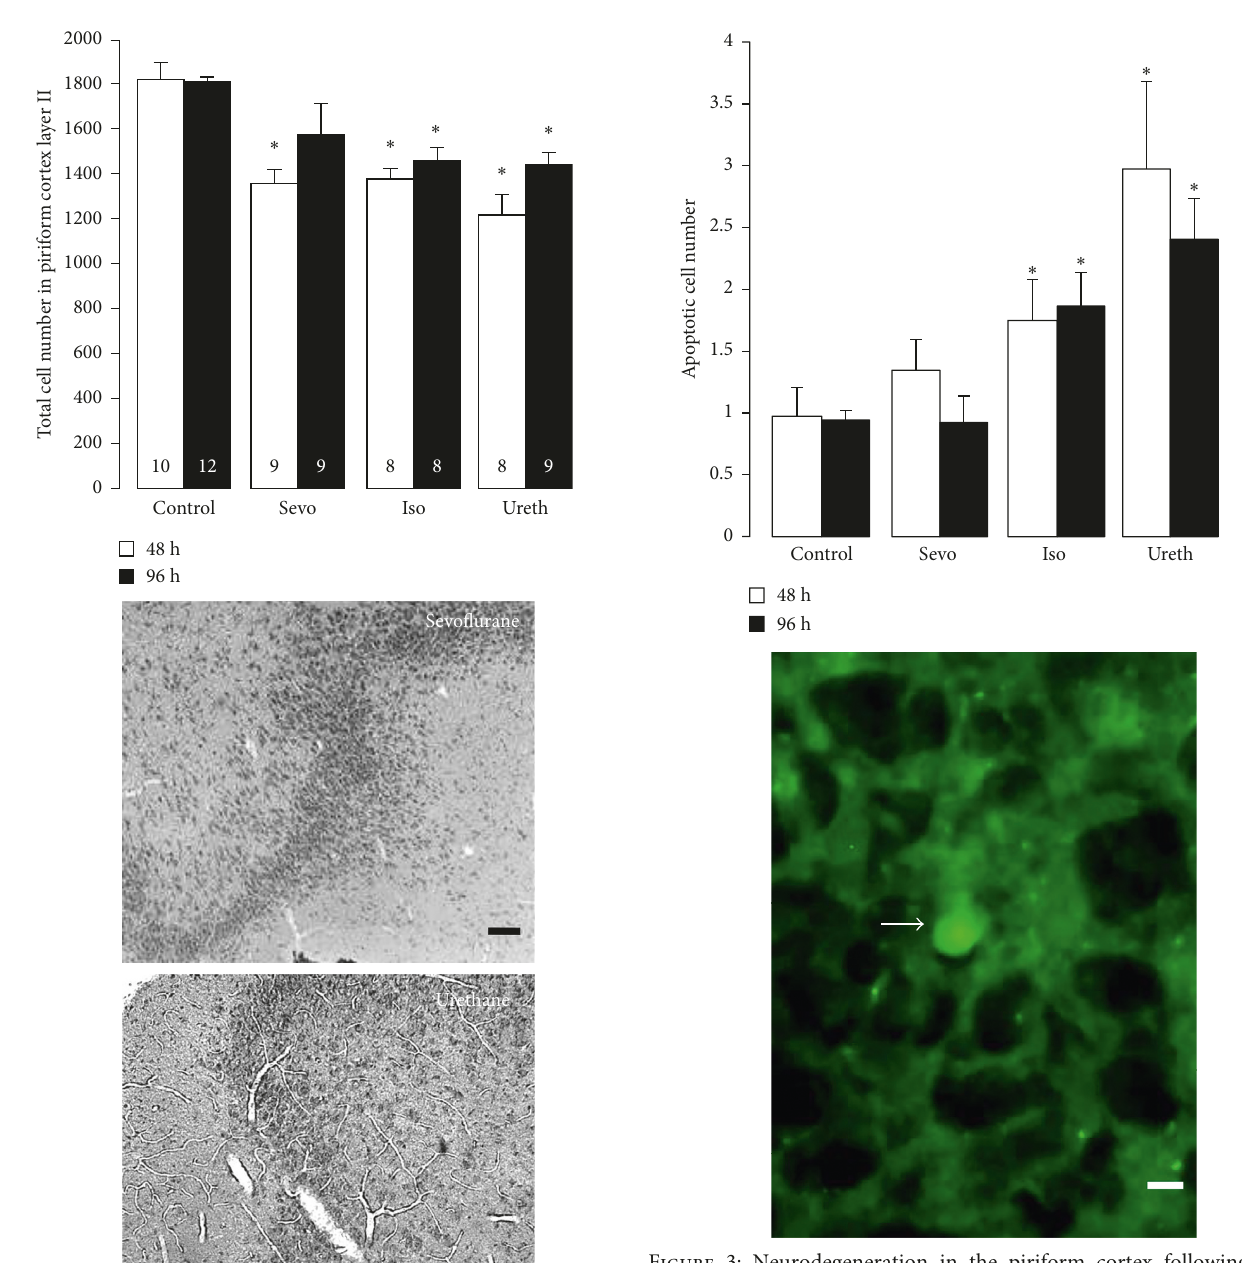
Figure 3: Neurodegeneration in the piriform cortex following anesthetic exposure. Data represent the mean SEM of total dying cells in layer II of the piriform cortex in animals sacrificed 48h and 96h after anesthetic exposure on PD15 (numbers of animals as per ± Figure 2). Dying cells were initially identified in sections stained Figure 2: Neuronal integrity in the piriform cortex following an- with H&E, as having a shrunken pyknotic nucleus set in an in- esthetic exposure. Data represent the mean SEM of total cell tensely eosinophilic cytoplasm. In serial eosin Y-stained sections, numbers in layer II of the piriform cortex in animals sacrificed 48h they also fluoresced brightly under UV light. The number of dying and 96h after anesthetic exposure on PD15. Values were calculated ± cells was calculated using unbiased stereological techniques, and using unbiased stereological techniques, and those differing signif- those differing significantly from vehicle-exposed controls are icantly from vehicle-exposed controls are indicated by an asterisk P indicated by an asterisk ( 0 . 05). Representative eosin Y-stained P ( 0 . 05). Representative images of H&E stained sections of the section of the piriform cortex (layer II) is shown under UV mi- ∗ piriform cortex (layer II) are also shown (scale bar 100 µ M). ∗ (cid:31) croscopy with a fluorescing, dying cell indicated by an arrow (scale < Pictures show the characteristically dense layer II, which is occupied < bar 20 µ M). The image is from an animal sacrificed 96h following primarily by the somata of pyramidal cells that receive direct input (cid:31) isoflurane exposure. Iso: isoflurane; Sevo: sevoflurane; Ureth: from the olfactory bulb upon their apical dendrites in layer I. These images are from animals sacrificed 96h following anesthetic expo- sure. Iso: isoflurane; Sevo: sevoflurane; Ureth: urethane.